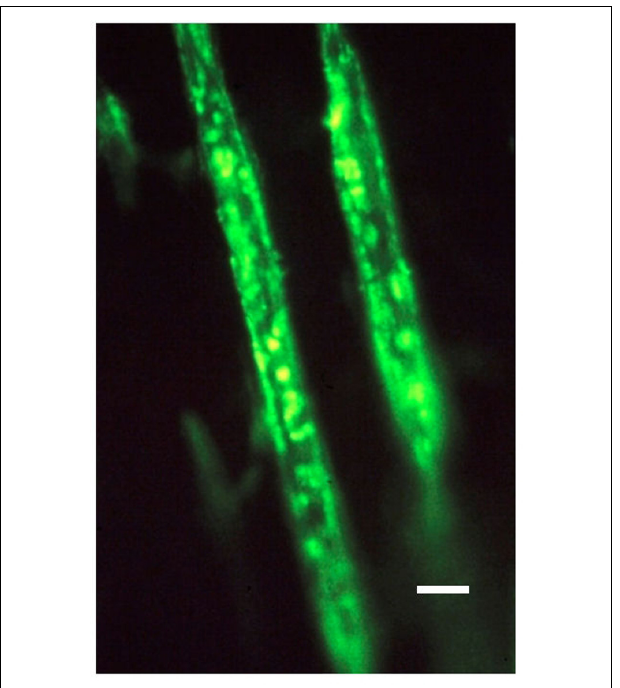
FIGURE 2 | Photomicrograph of two typical representative collagen type III-rich Sharpey’s fibers, about 10 μ m thick, and fluorescing positive within the negative calcified bone matrix. Human proximal femur. FITC-immunostain for CIII, UV epifluorescence microscopy. Scale bar 10 μ m. After Carter etal.